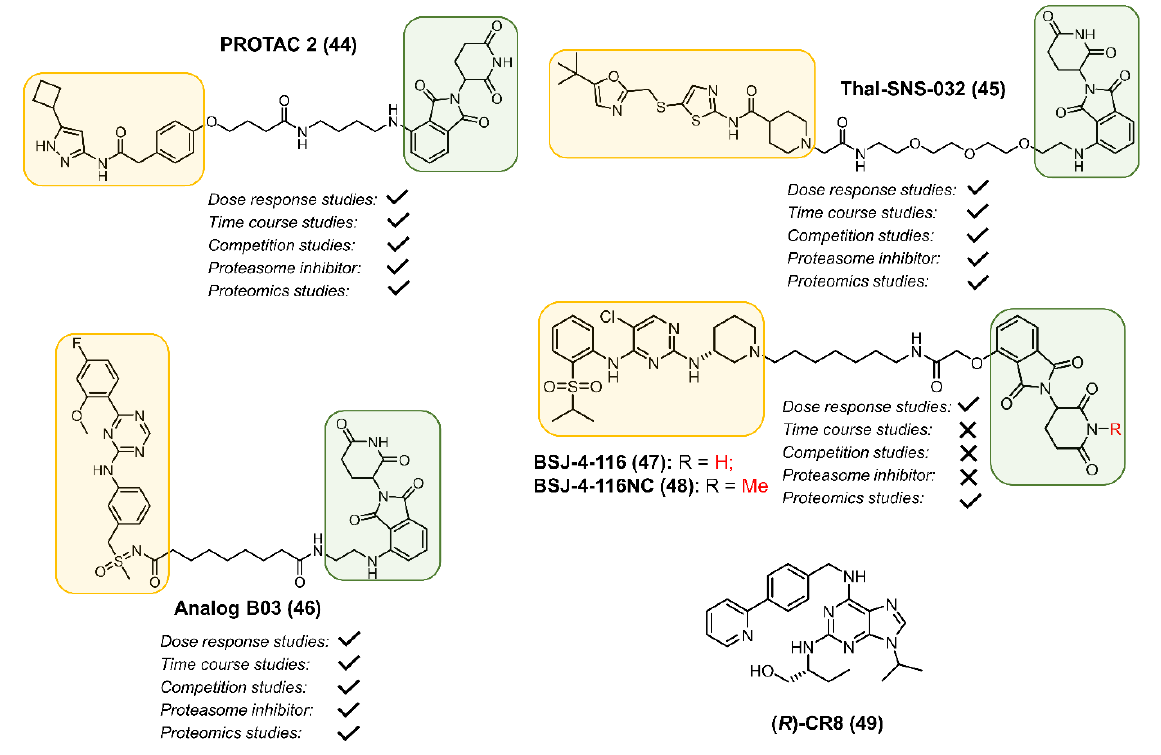
Figure 8. Structures of CDK9 PROTACs ( 44 – 46 ), CDK12 ( 47 ) PROTAC and a Cyclin K molecular glue ( 49 ).